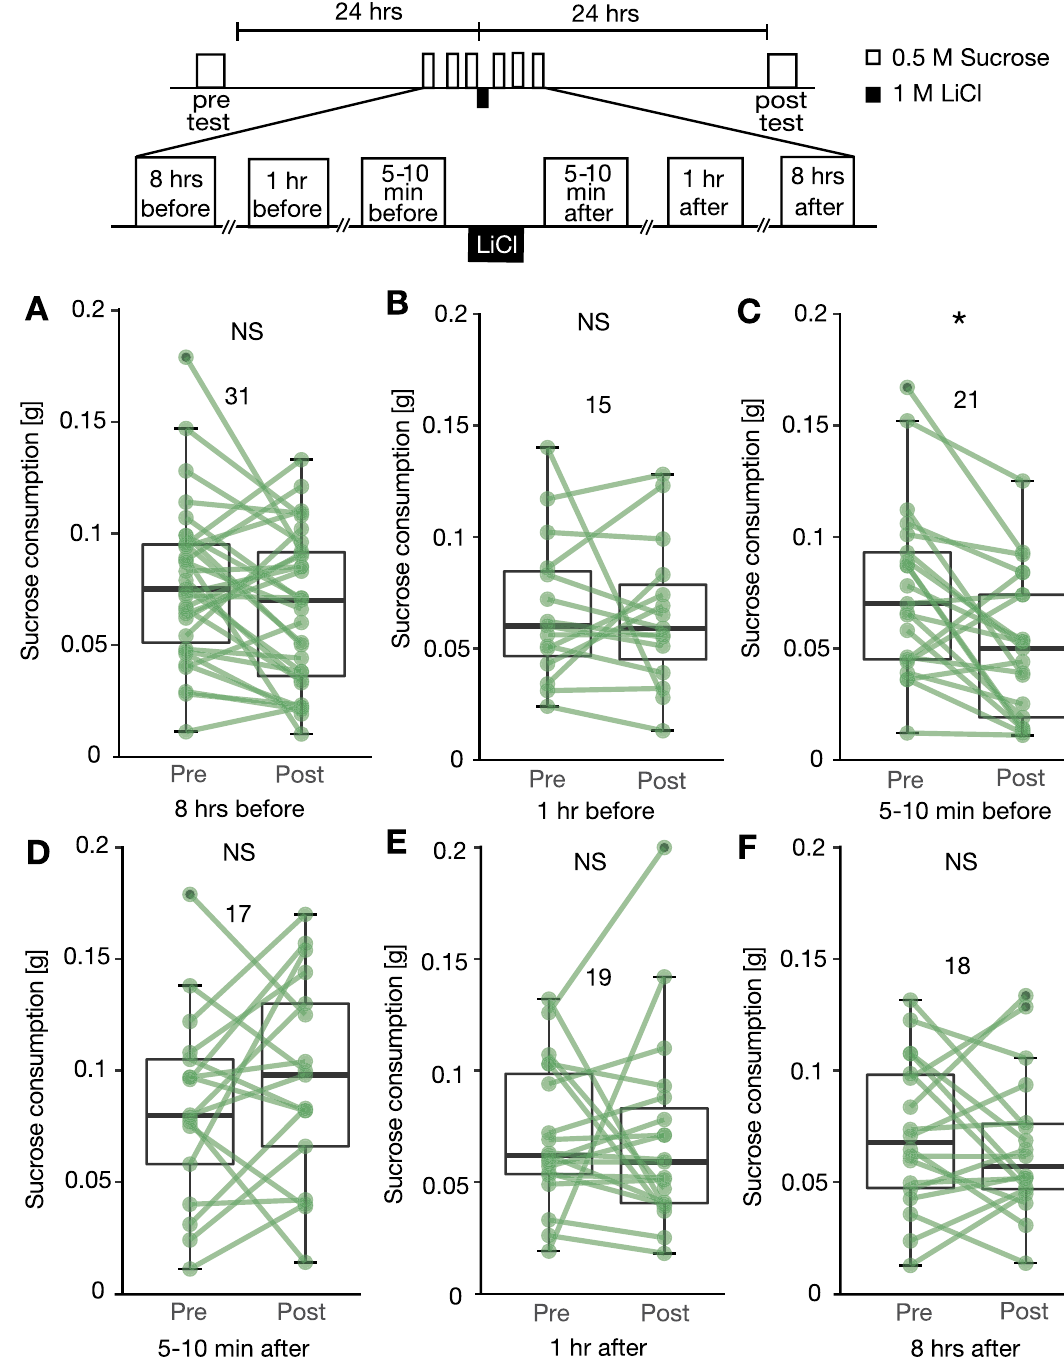
Figure 3. Effects of CTA training with different intervals between sucrose ingestion and LiCl injection. Five groups of crickets received an initial 2.5-min consumption test, and the next day they were allowed to ingest 100 µl of 0.5 M sucrose solution at various times before and after injection of LiCl. All of the groups received 2.5-min sucrose consumption at 24 h after LiCl injection. The Wilcoxon test was used for statistical comparisons of amounts of sucrose consumption before and after CTA training (**P < 0.01, ns: not